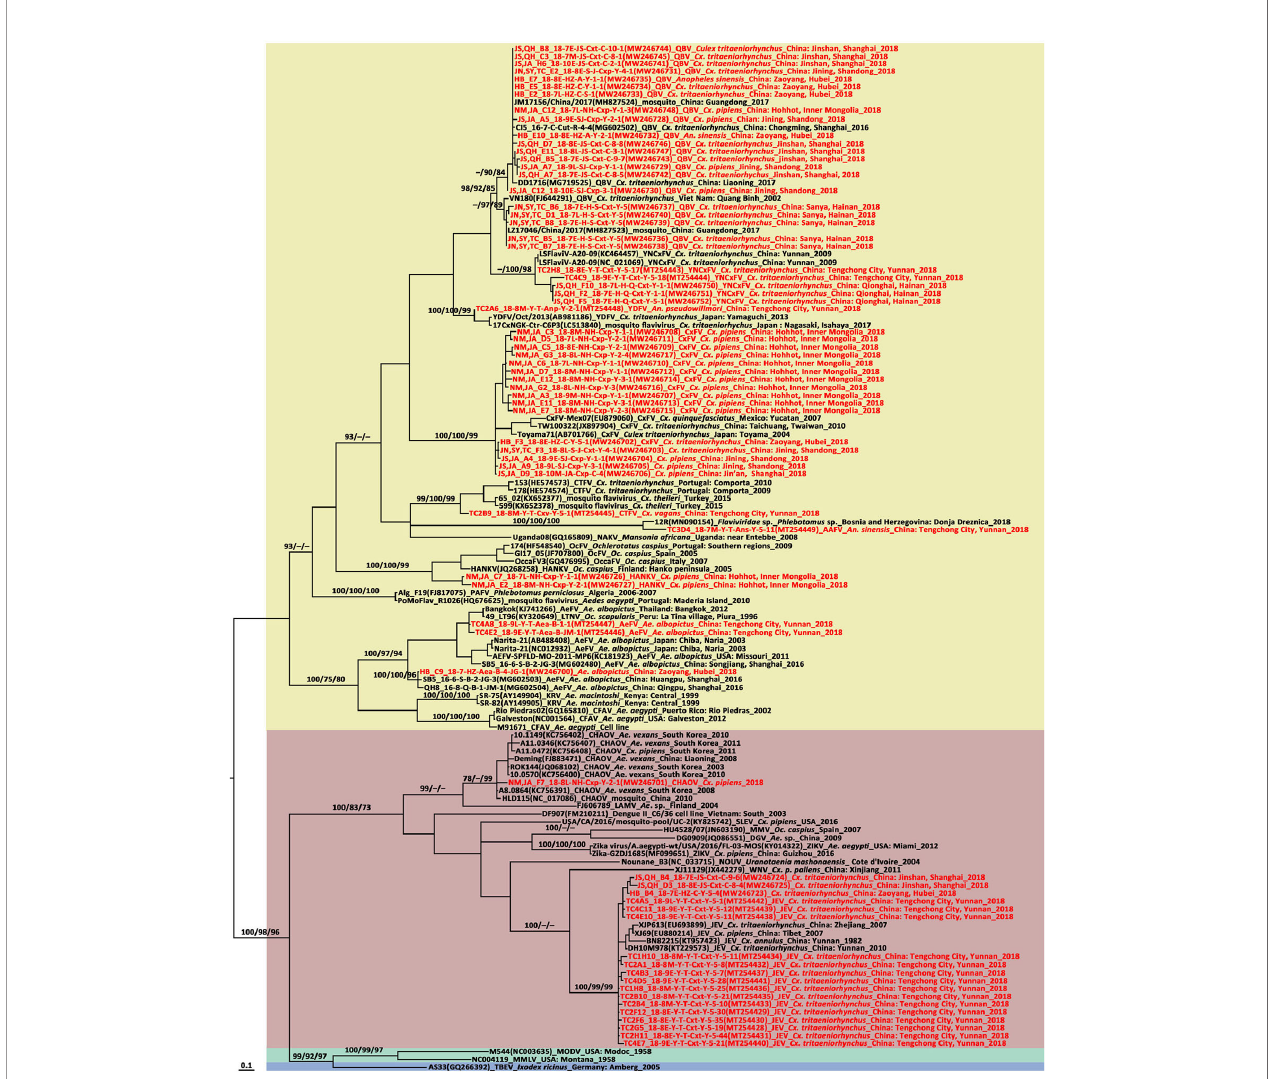
FIGURE 2 | Phylogenetic tree generated by Bayesian analysis of partial non-structural fi ve gene sequences of fl avivirus. The virus strain, GenBank accession number, host, collection country and year are noted. The fl avivirus sequences obtained in this study are marked in red. Bootstrap values (1,000 replicates, not shown for less than 75%) of maximum likelihood; Bayesian analyses and neighbor-joining are shown above the main lineages. The bar indicates 0.1 substitutions per site. Sequences shaded sky blue represent tick-borne fl avivirus, those shaded aquamarine represent no-known vector fl avivirus, those shaded khaki represent infect speci fi c fl avivirus, those shaded rose-brown represent mosquito-borne fl avivirus. AAFV, Anopheles associated fl avivirus; AeFV, Aedes fl avivirus; CFAV, cell fusing agent virus; CTFV, Culex theileri fl avivirus; CxFV, Culex fl avivirus; DGV, Donggang virus; HANKV, Hanko virus; JEV, Japanese encephalitis virus; KRV, Kamiti River virus; LTNV, La Tina virus; MMLV, Montana myotis leukoencephalitis virus; MODV, Modoc virus; NAKV, Nakiwogo virus; PAFV, Phlebotomus associated fl avivirus; QBV, Quang Binh fl avivirus; OcFV, Ochlerotatus caspius fl avivirus; SLEV, Santa Louis encephalitis virus; TBEV, tick-borne encephalitis virus; WNV, West Nile virus; YDFV, Yamadai fl avivirus; YNCxFV, Yunnan Culex fl